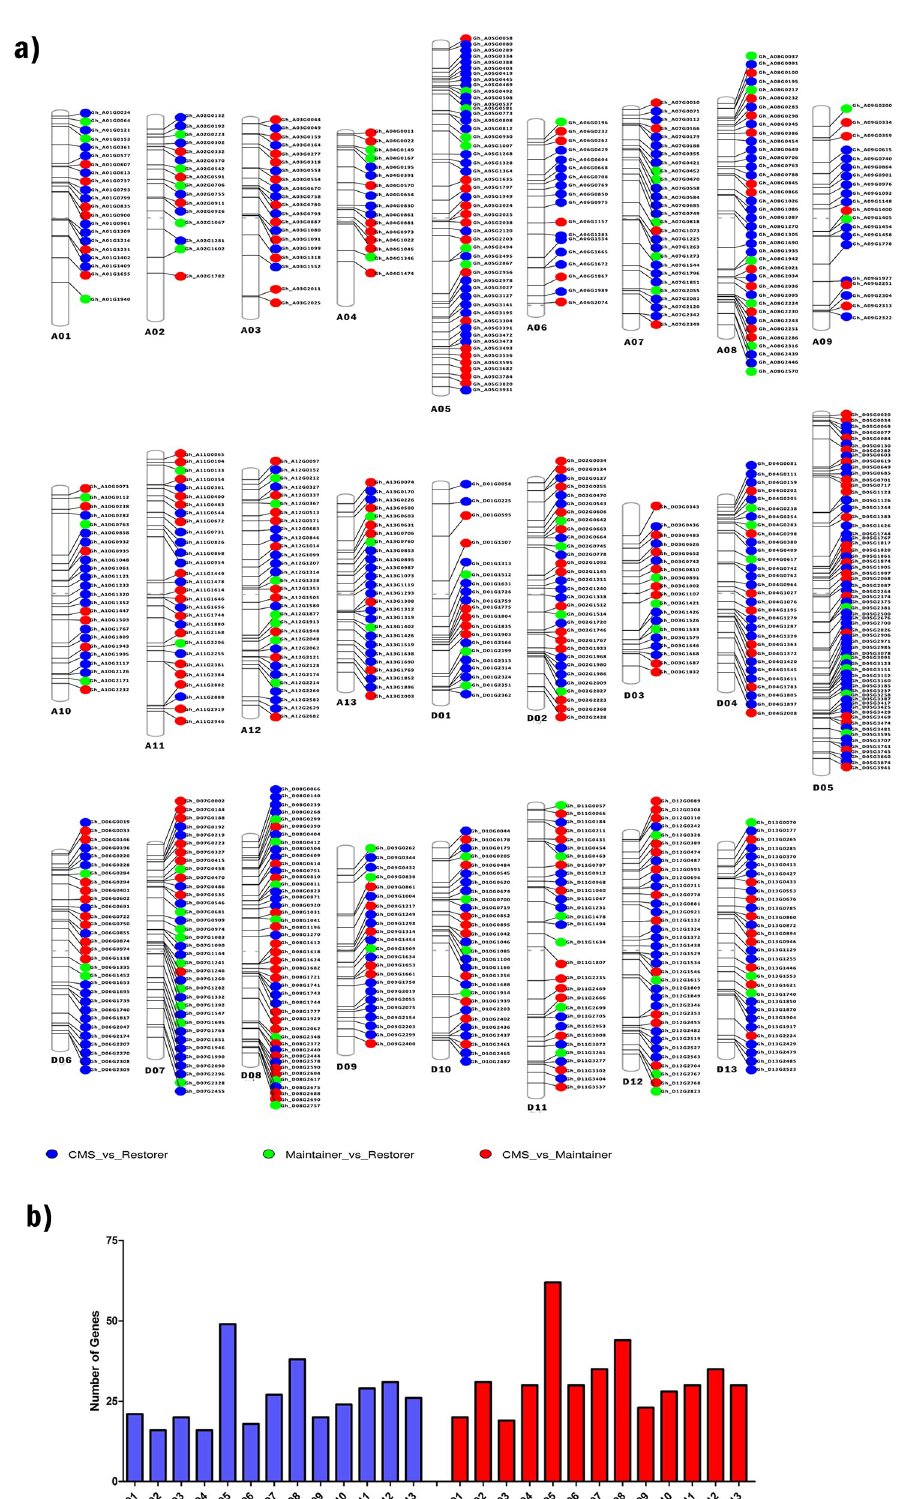
Fig 4. a) Distribution of differentially expressed genes on chromosomes of Gossypium hirsutum L . Distribution of phenogram showing the exact location of DEGs on each chromosome of Gossypium hirsutum L. b) The total